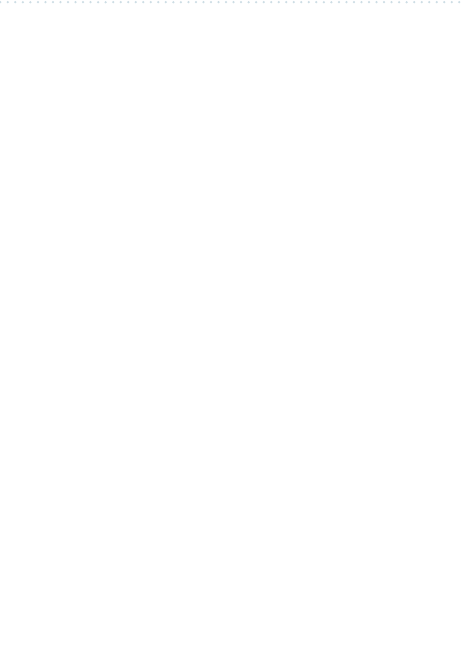
Figure 3. The abundance of amplicon sequence variants is significantly different in the depressed cohort: Differential abundance analysis identified 21 ASVs (that cover 13 genera and 6 phyla) that had a significantly altered abundance in the depressed cohort compared with healthy controls (padj < 0.05). ( A ) Differential abundance in 4 ASVs resolving to highest taxonomic level genus; ( B ) Differential abundance in ASVs with species level resolution.